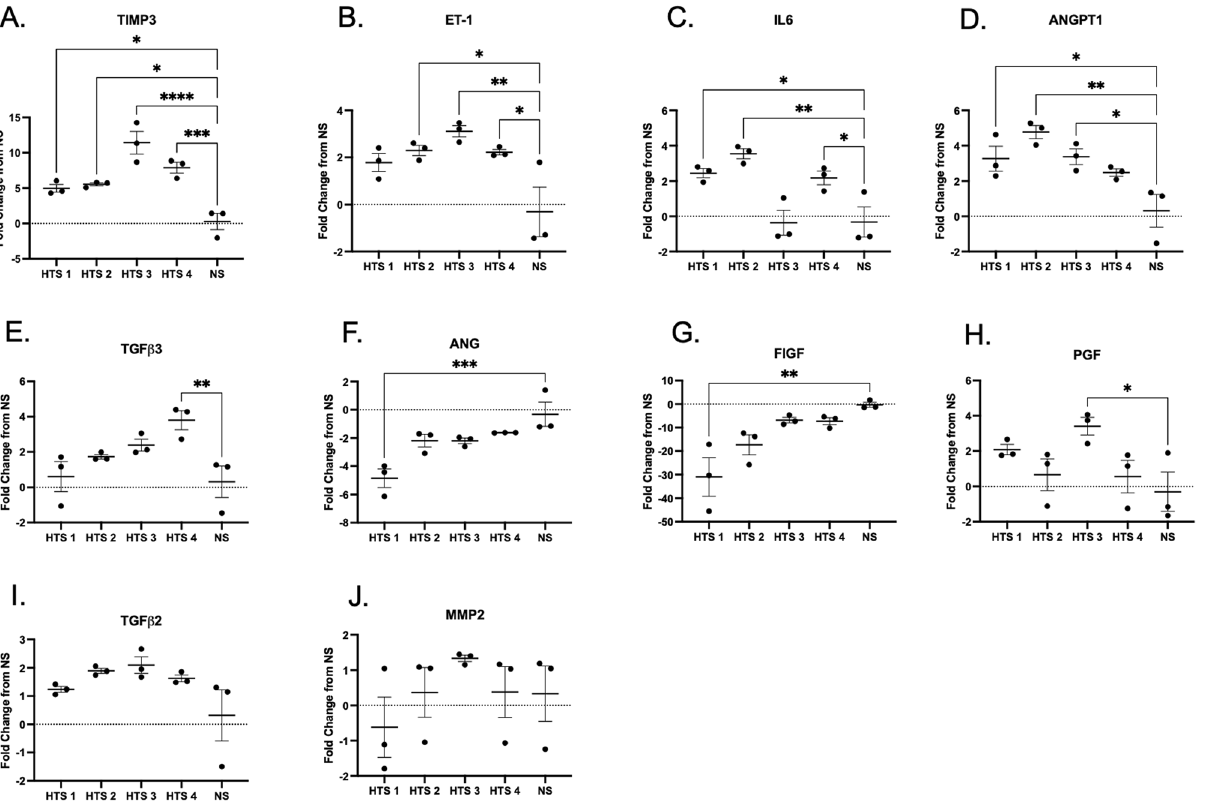
Figure 6. Differences in expression of highly differentiated genes are confirmed with qRT-PCR. Animal 2 excisional HTS DMVECs and NS DMVECs gene expression measured by qRT-PCR for TIMP-3 ( A ), ET-1